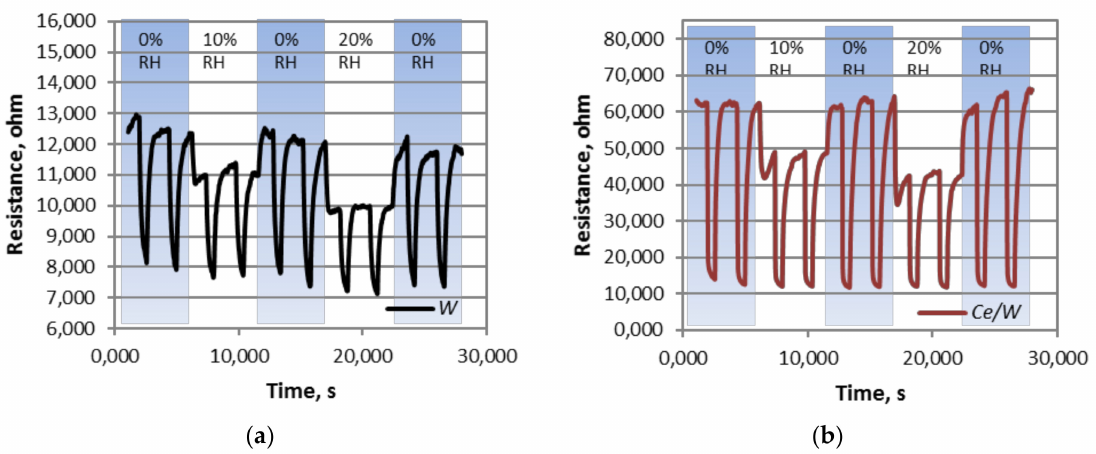
Figure 10. The resistance changes registered for ( a ) W and ( b ) Ce / W to acetone in dry and humid ambient (RH: relative